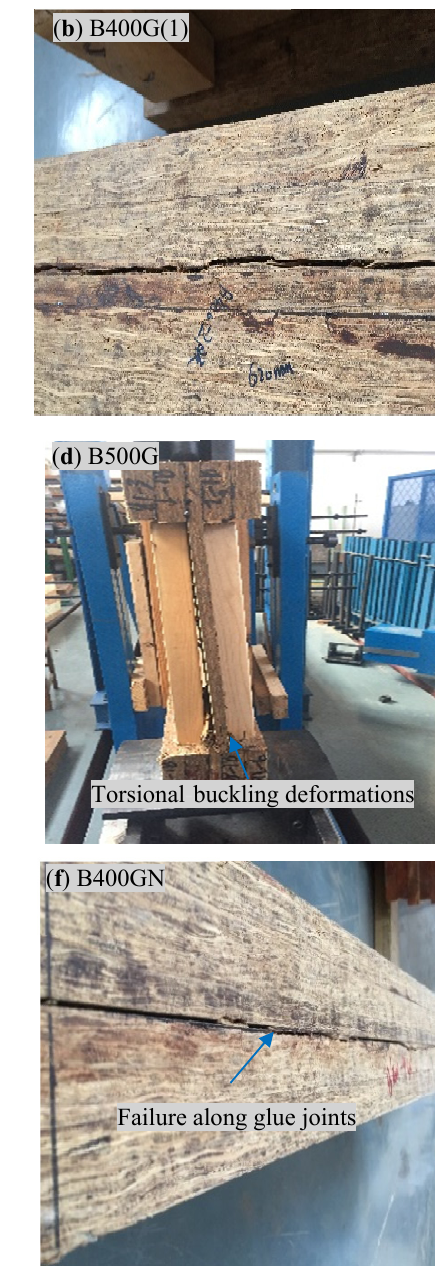
Figure 4. I-beam failure modes in the short beam shear test.